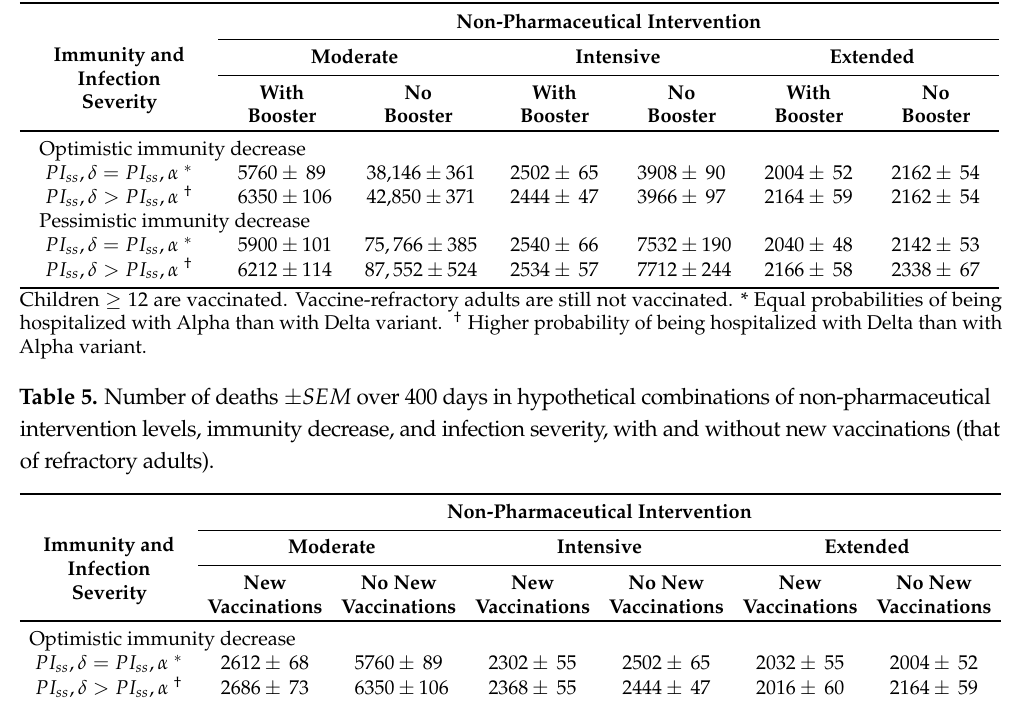
Table 4. Number of deaths ± SEM over 400 days in hypothetical combinations of non-pharmaceutical intervention levels, immunity decrease, and infection severity, with and without a booster dose of vaccine given to all previously vaccinated individuals.